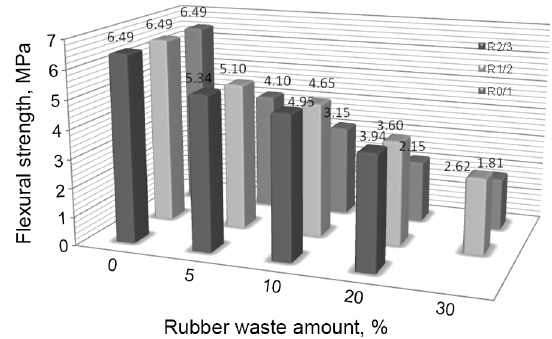
Fig. 5. The change in the flexural strength of concrete with CR of different amount and size fraction